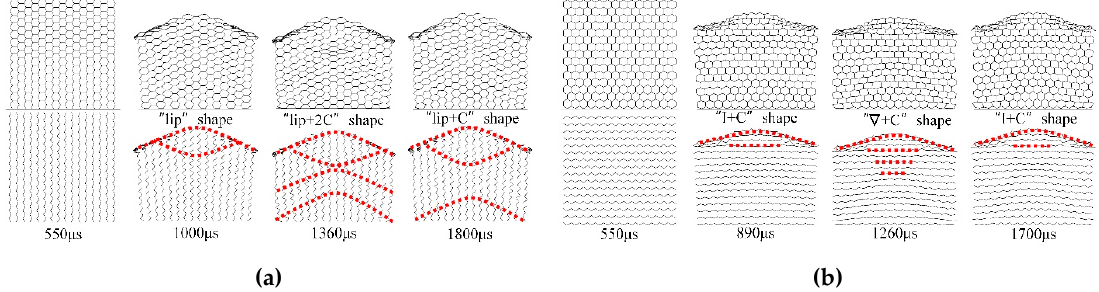
Figure 7. Deformation modes in the H-RP. (a) 10 g X1 -H-RP and (b) 10 g X2 -H-RP.